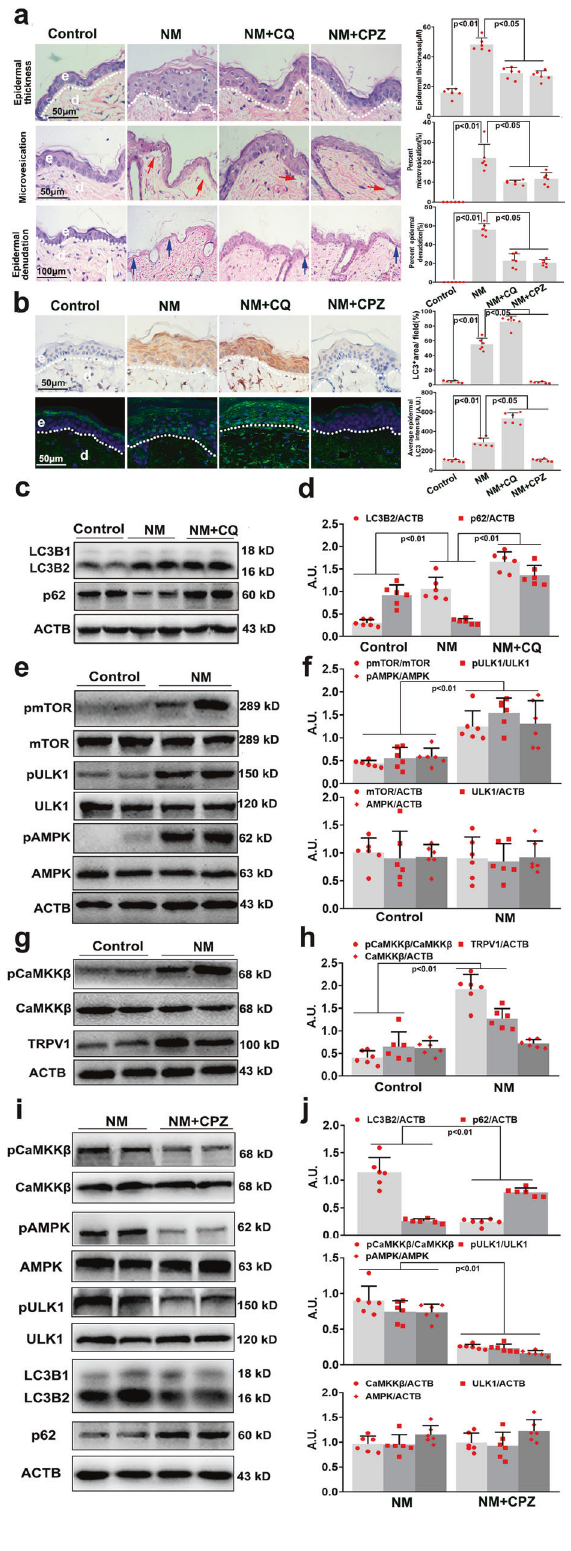
Fig. 8 NM-induced autophagy via activating the TRPV1 signaling pathway in the skin of SKH-1 hairless mice. The dorsal skins of 6- week-old male SKH-1 hairless mice with 24 g~26 g weighing ( n = 6 per group) were treated with CQ (60 mg/kg, i.p.) or CPZ (5 mg/kg, i. p.), they were exposed to 3.2 mg NM in 200 μ L acetone as described in the Materials and Methods. Mice were sacri fi ced at 24 and 72 h following NM exposure, and dorsal skin tissue was collected and fi xed in 10% formalin for histopathological analysis or snap frozen in liquid nitrogen for western blot analysis. a At 24 h or 72 h after NM exposure, skin wounds and nearby tissues were collected and H&E staining was performed for analysis of epidermal thickness (top), microvesication (middle), and epidermal denudation (bottom). e, epidermis; d, dermis; red arrows, microvesication; blue arrows, epidermal denudation. b At 24 h after NM exposure, the skin wounds and nearby tissues were collected and LC3B expression was detected by immunohistological analysis (top) and immuno fl uores- cence analysis (bottom). e, epidermis; d, dermis. The skin tissues were harvested at 72-h post NM exposure and lysed, and western blot analysis was performed. c The formation of LC3B2 and the degradation of p62 were measured. d The bar graphs show the quanti fi cation of LC3B2 and p62. e The levels of mTOR, pmTOR, ULK1, pULK1, pAMPK, and AMPK were measured. f The bar graphs show the quanti fi cation of the indicated proteins. g The expression of TRPV1, pCaMKK β , and CaMKK β was measured. h The bar graphs show the quanti fi cation of the indicated proteins. i The expression of the indicated protein was detected by western blotting. j The bar graphs show the quanti fi cation of indicated proteins. Values are expressed as the means ± SD ( n = 6); A.U. arbitrary